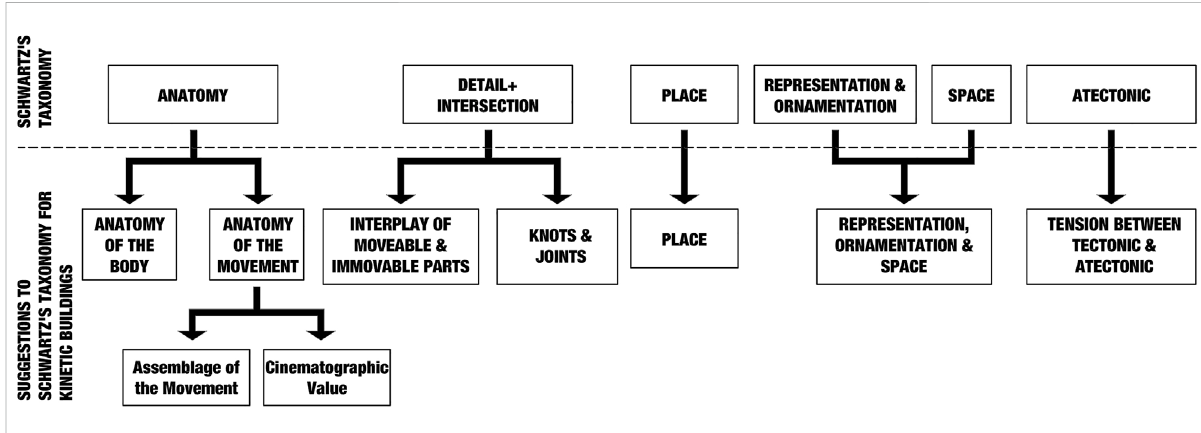
FIGURE 3 Suggestions to Schwartz ’ s Taxonomy (Drawn by the